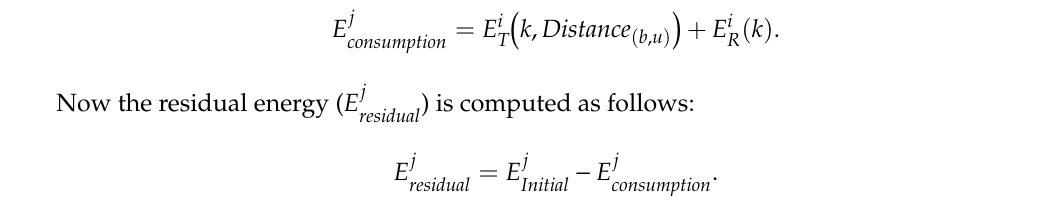
Figure 4. Unknown nodes with direct and indirect communication.